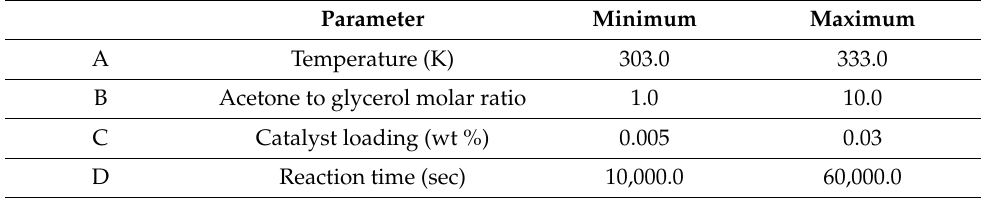
Table 3. Input parameters and their ranges of the investigation.